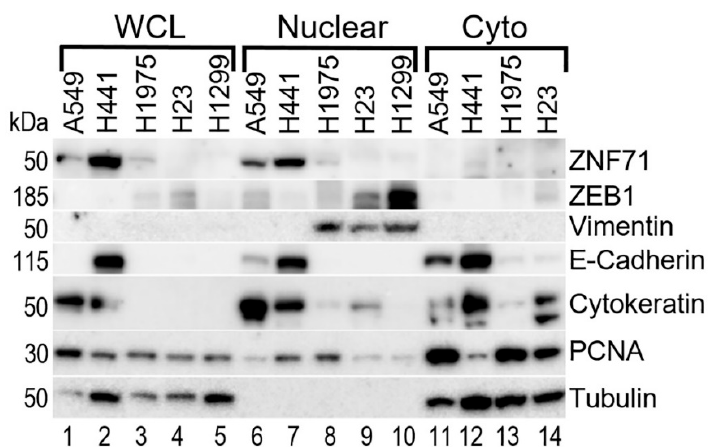
Figure 4. Correlation of expression of ZNF71 with EMT markers in five NSCLC cell lines. Western blotting analysis of ZNF71 , mesenchymal and epithelial markers in the indicated cell lines. PCNA and Tubulin—loading controls. WCL—whole cell lysate, Nuclear and Cyto—nuclear and cytoplasmic fractions isolated from the same cell lines.